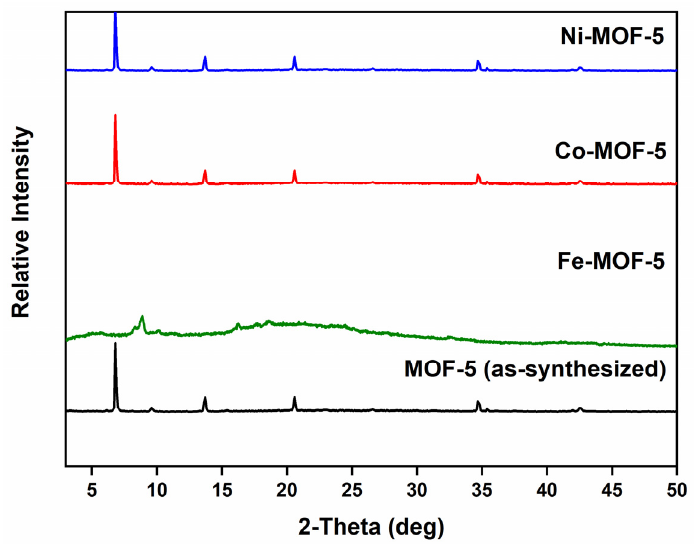
Figure 3. PXRD patterns of the as-synthesized MOF-5 and metal-exchanged M-MOF-5 (obtained from a 0.5 M concertation of metal ions).